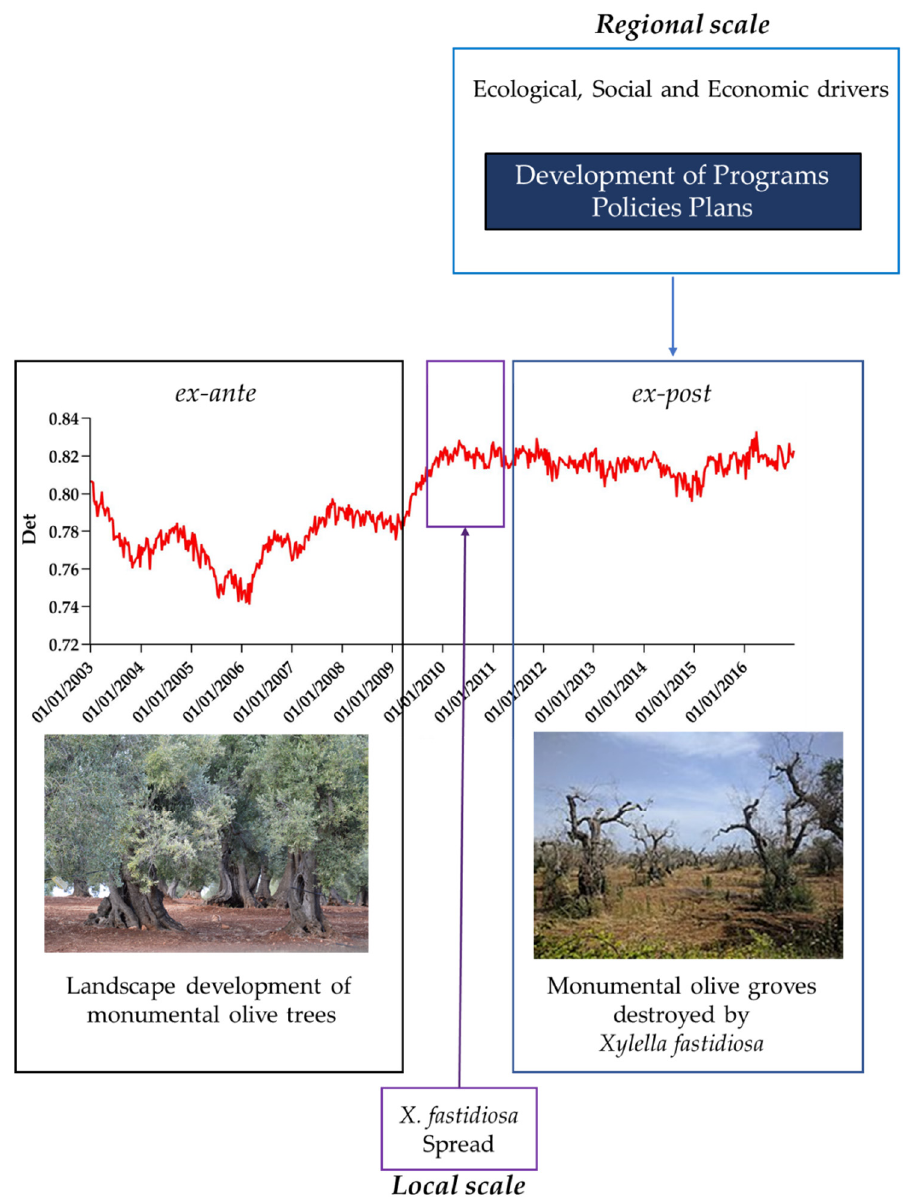
Figure 13. Interpretation of the Det evolution of recurrence analysis considering regional and local